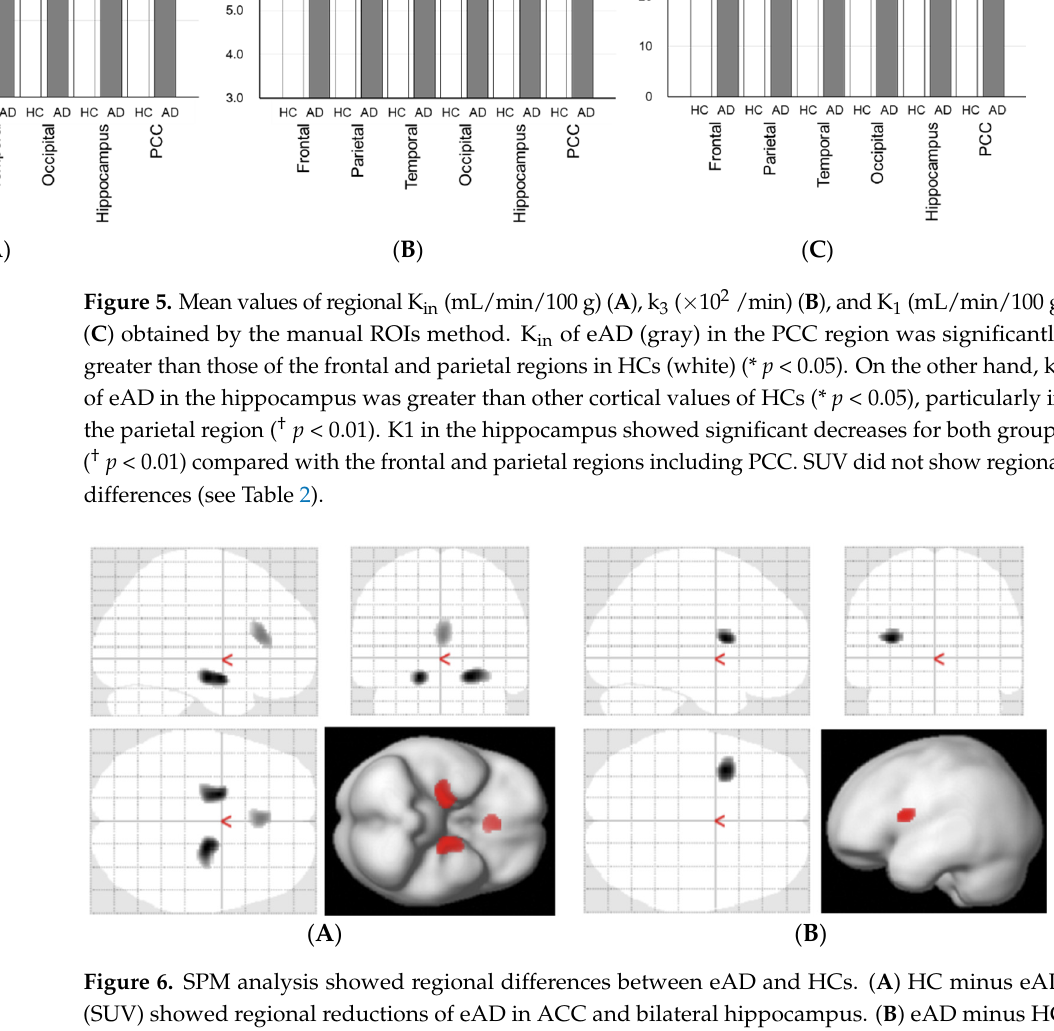
Figure 6. SPM analysis showed regional differences between eAD and HCs. ( A ) HC minus eAD (SUV) showed regional reductions of eAD in ACC and bilateral hippocampus. ( B ) eAD minus HC (K in ) showed a regional increase in left central operculum of eAD.